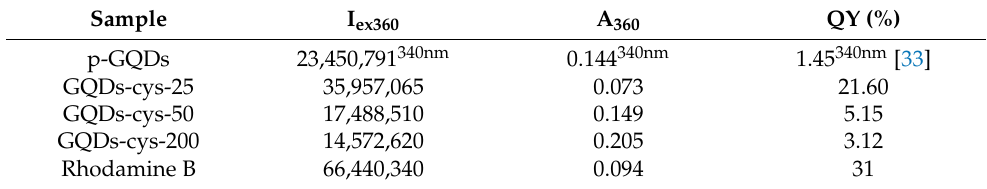
Table 2. Values of integrated surface for emission spectra at excitation wavelength 360 nm, absorbance at 360 nm and calculated